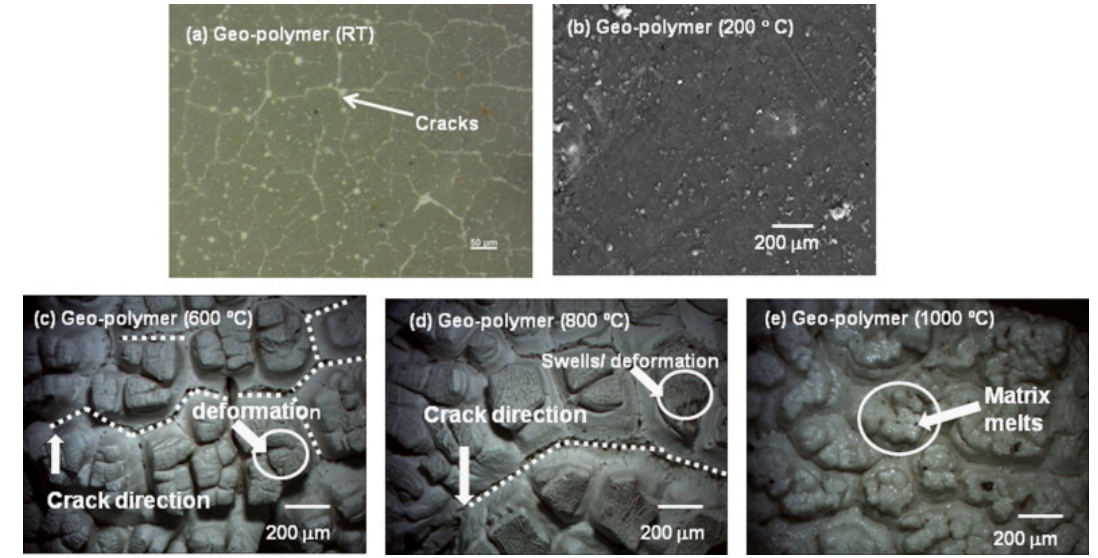
Figure 7. Surface morphology ( a ) geopolymer at RT shows the minor cracks; ( b ) geopolymer after exposure to temperature of various temperatures from ( c – e ) 200 to 1000 °C.